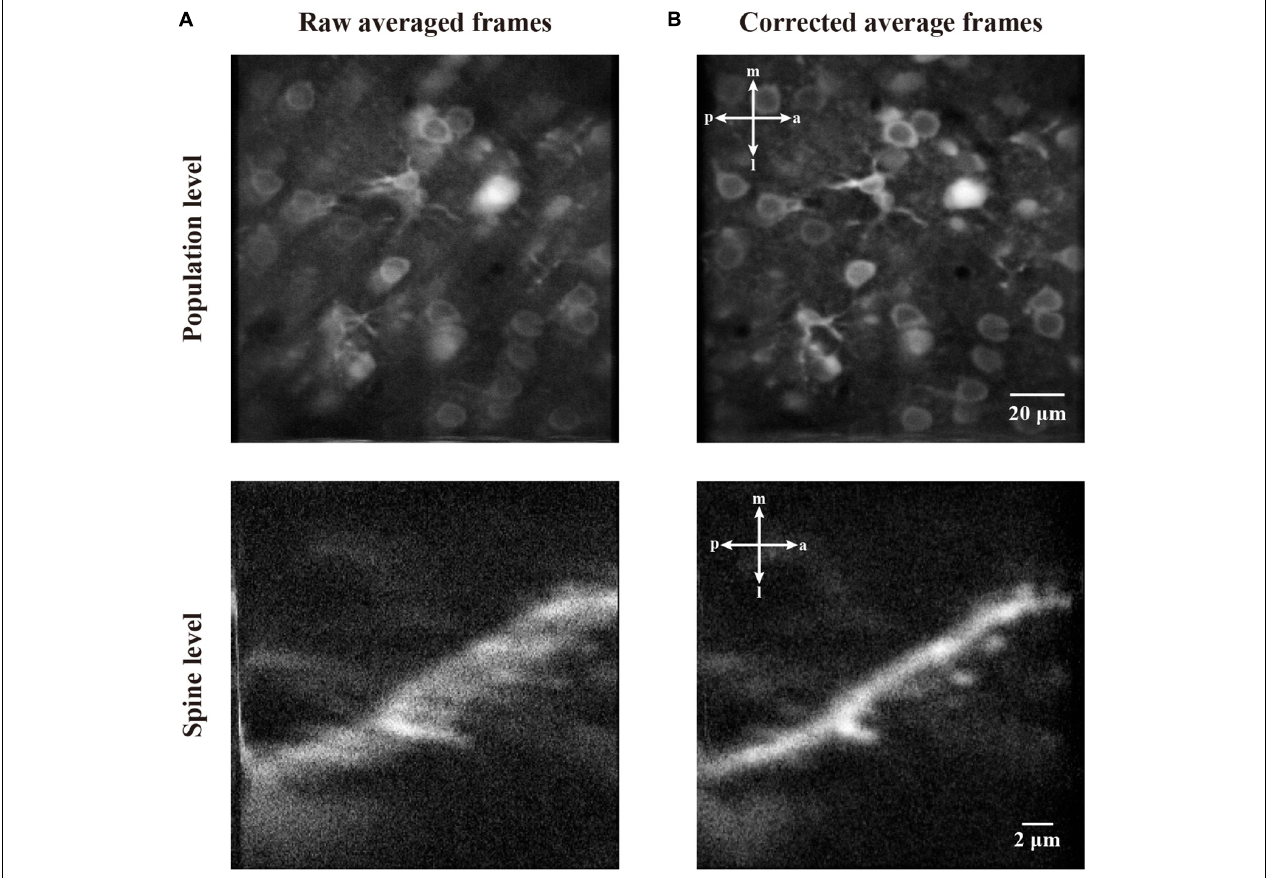
FIGURE 11 | The correction effect in average frame of two-photon imaging data. (A) The average of raw frames at population level and spine level. (B) The average of motion corrected frames at population level and spine